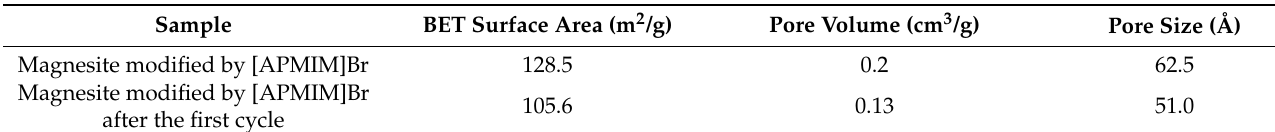
Table 3. Porous structure parameters determined from N 2 adsorption-desorption isotherms.